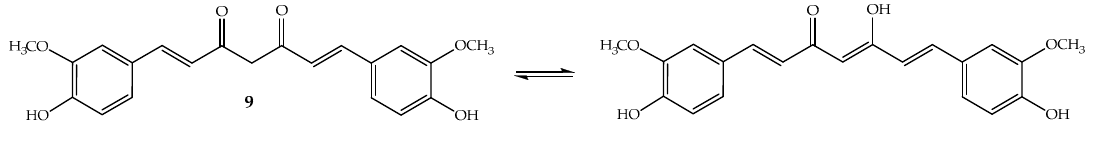
Figure 6. Chemical structure of the polyphenol curcumin ( 9 ).